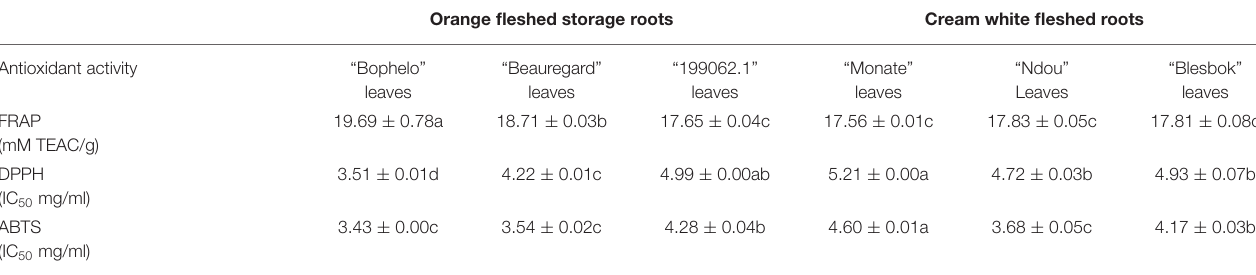
TABLE 3 | Comparison of the antioxidant activities of the leaf extracts of four South African sweet potato varieties with the USA’s Beauregard and Peru’s